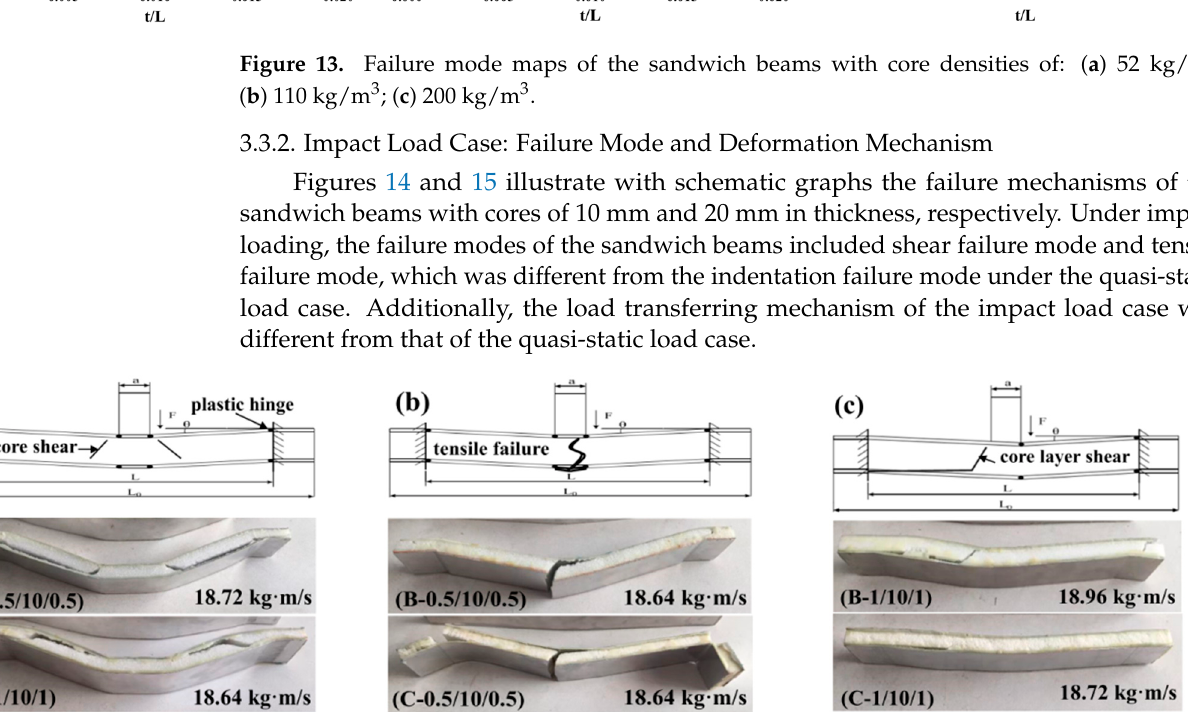
Figure 13. Failure mode maps of the sandwich beams with core densities of: ( a ) 52 kg/m 3 ; ( b ) 110 kg/m 3 ; ( c ) 200 kg/m 3 .